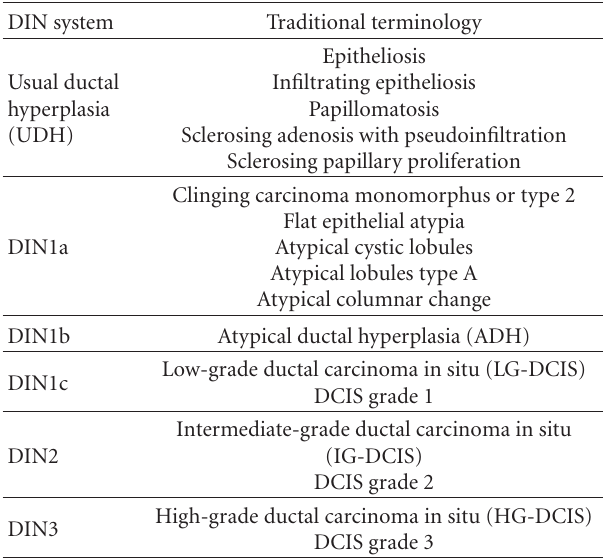
Table 1: Terminology of